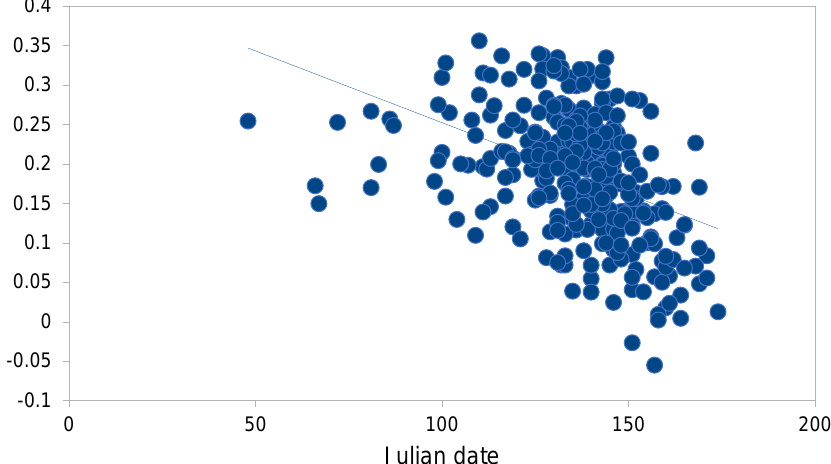
Figure 3. Relationship between Julian date and female body condition of breeding Tawny Owls Strix aluco in the studied population in southern Finland (f(x) = −0.002x + 0.434, r = −0.424, df = 330, p < 0.001).